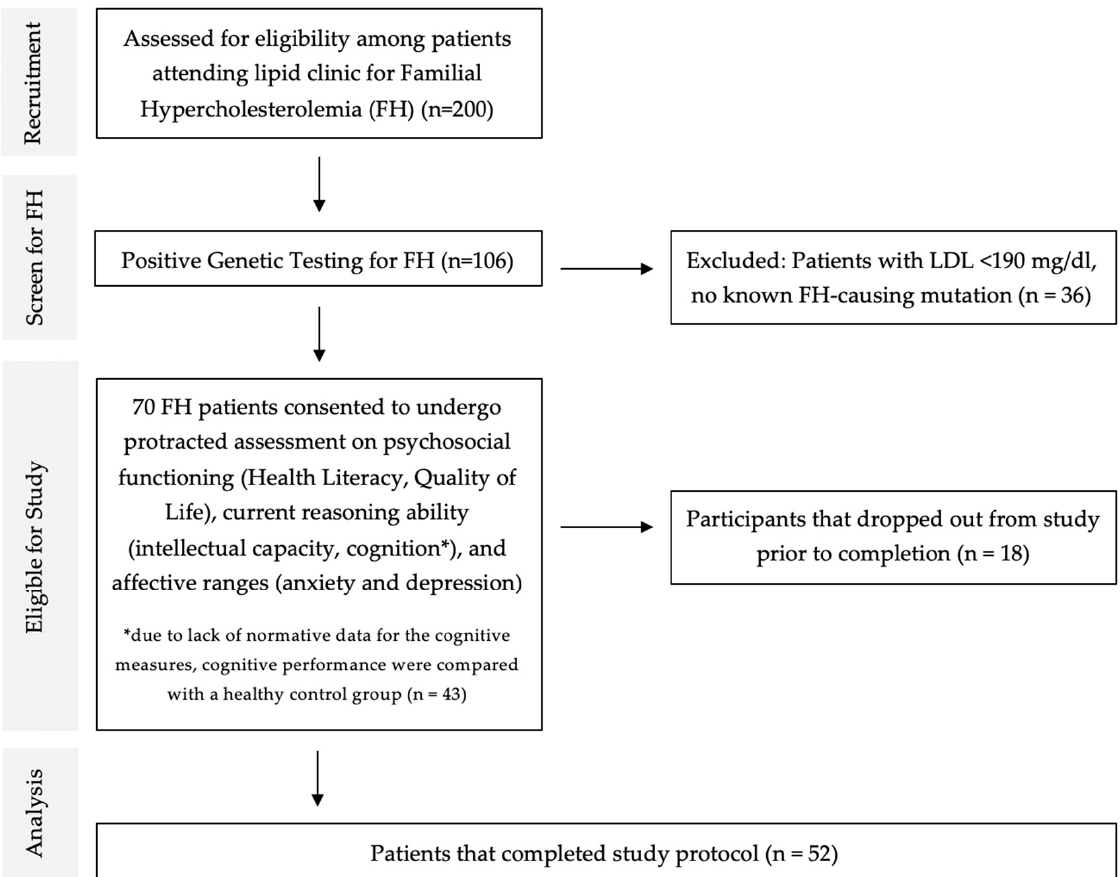
Figure 1. Flowchart indicating the process of participant recruitment for the current